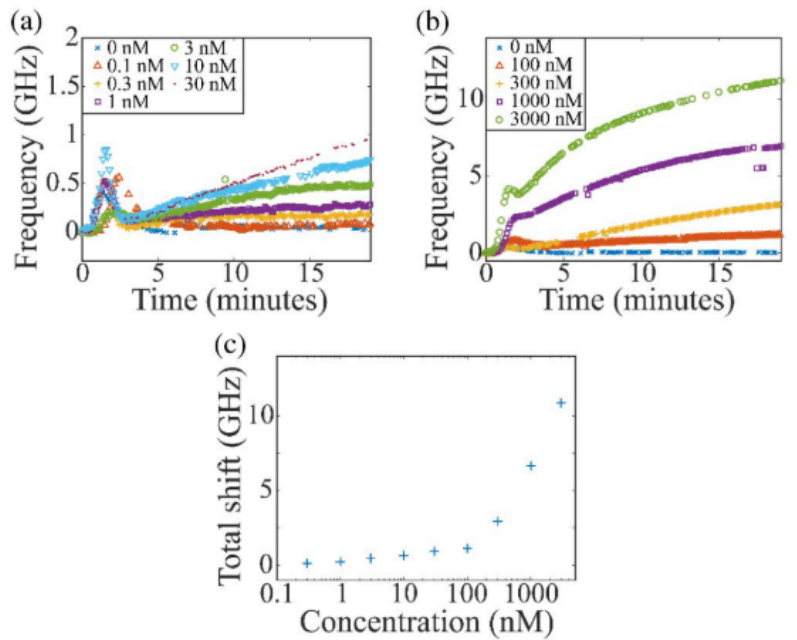
Figure 23. Frequency shifts as a result of protein rhS100A4 binding. ( a ) depicts the low set of concentrations ranging from 0–30 nM, while ( b ) depicts higher order concentrations up to 3000 nM. ( c ) is the calibration curve for log concentrations versus the total frequency shift. Reproduced from ref. [117] with permission © The Optical Society of America.